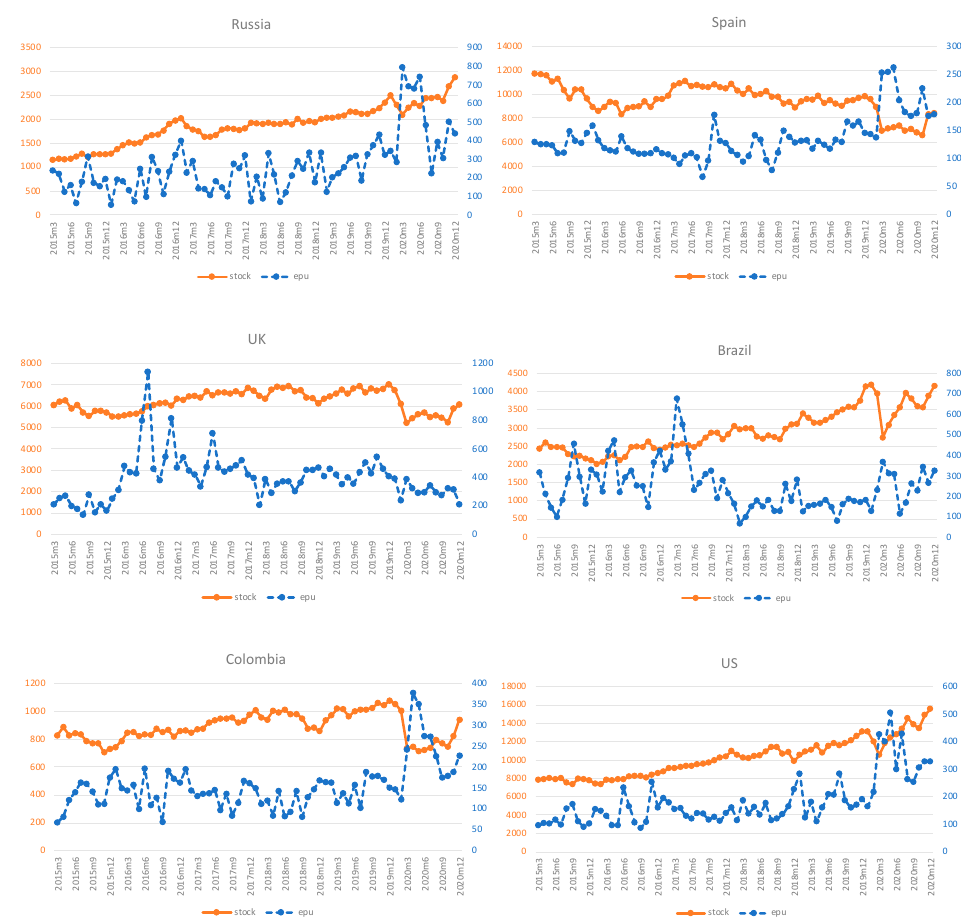
Figure 1. The movement of sustainable stock market price and EPU for 12 countries.